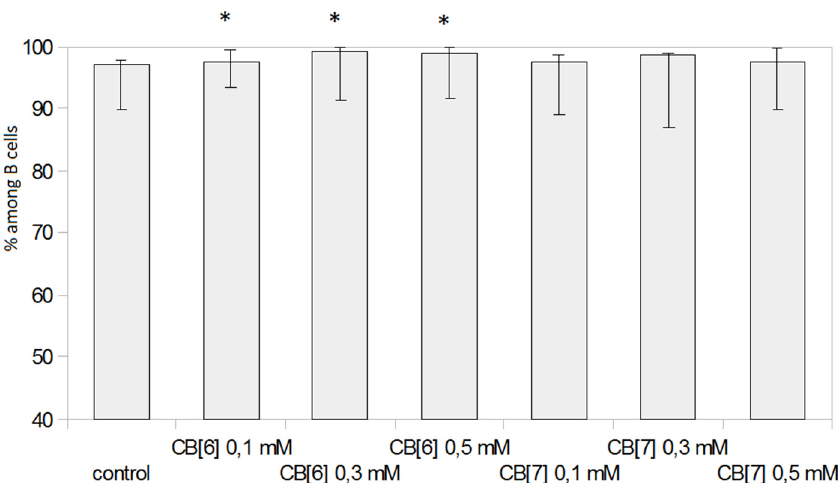
Figure 7. E ff ect of CB[n] on the HLA-DR expression on CD19 + B cells after seven days of cultivation. (* Indicates a significant di ff erence ( p < 0.05) vs. the Figure 7. Effect of CB[n] on the HLA ‐ DR expression on CD19+ B cells after seven days of cultivation. (*Indicates a significant difference ( p < 0.05) vs. the control.)